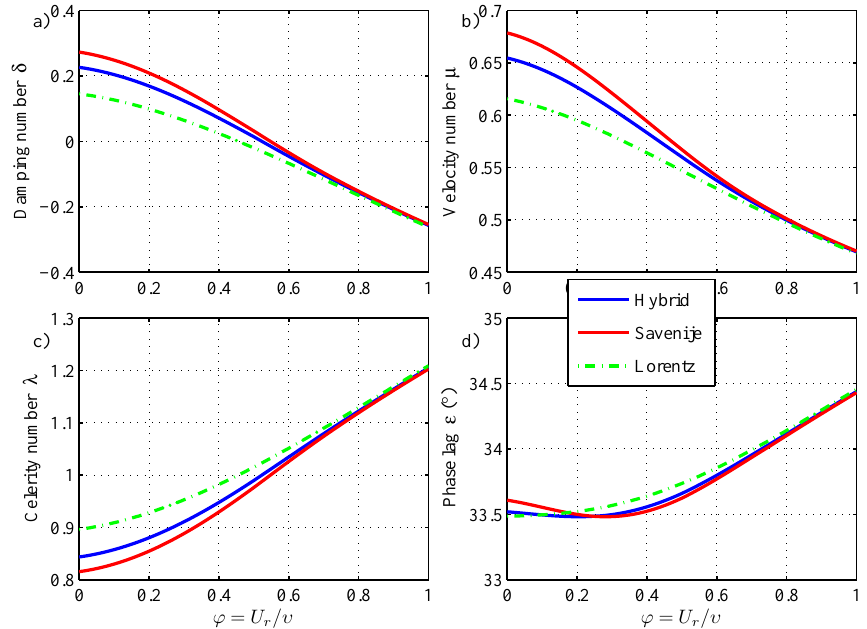
Fig. 4. The main dimensionless parameters (damping number δ , velocity number µ , celerity number λ and phase lag ε ) obtained with the different analytical methods as a function of dimensionless river discharge ϕ with ζ 0 =0.1, γ =1.5, χ =20 and r S